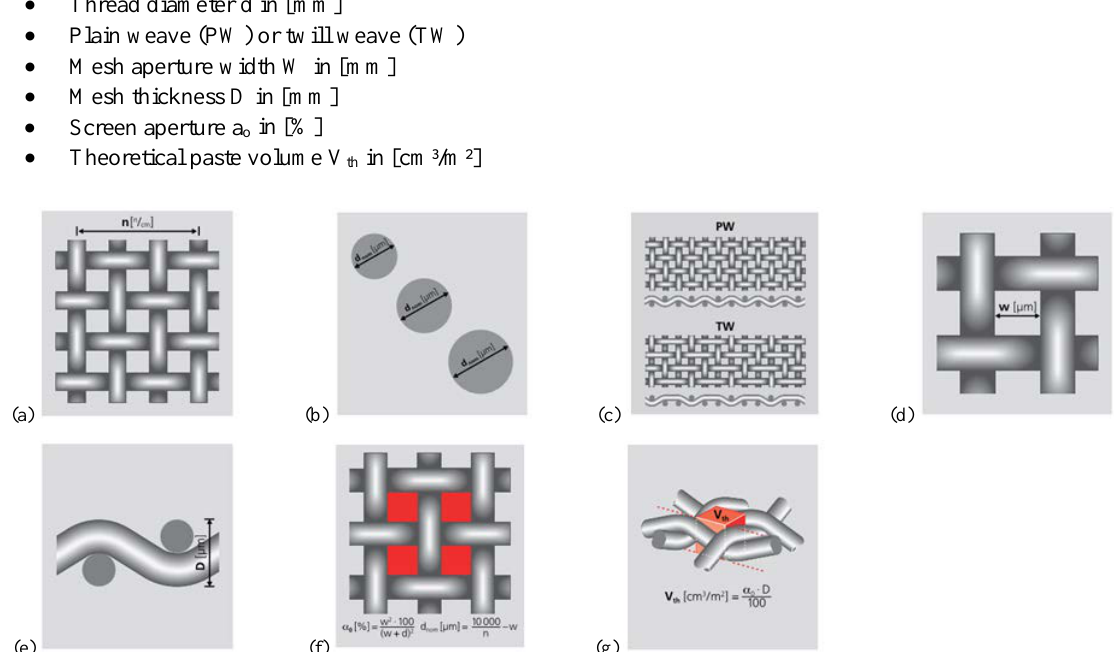
Fig. 2 Parameters of mesh geometry and their definition (adapted from Spirig and Sefar, 2017). (a) Number of threads n, (b) thread diameter, (c) weave type PW (plain weave) or twill weave (TW), (d) mesh aperture width W, (e) mesh thickness D, (f) screen aperture a o , (g)